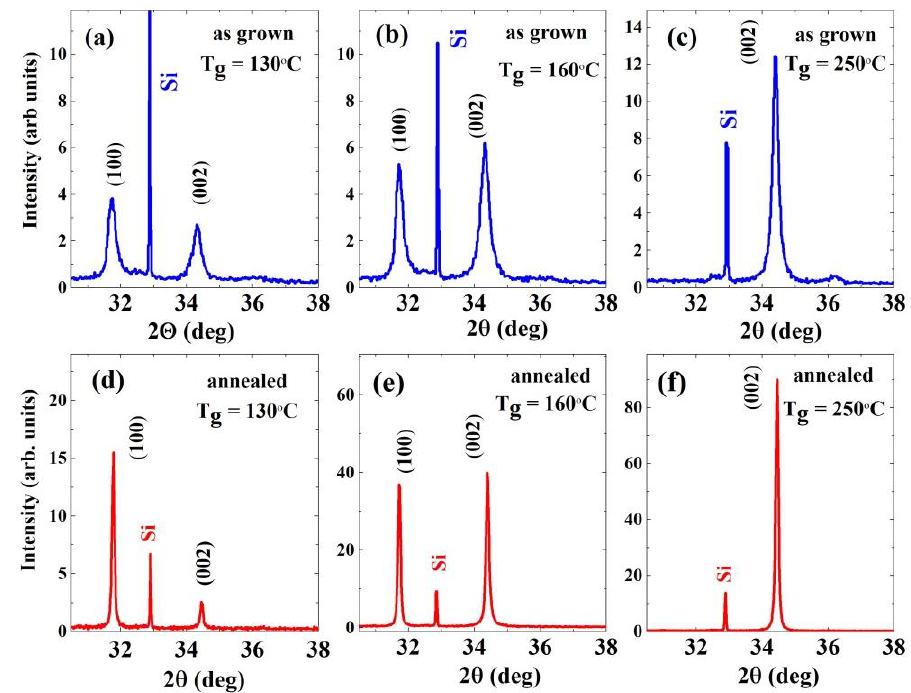
Figure 1. X-ray diffractograms of as grown ( a – c ) and annealed ( d – f ) ZnO/Si (100) films grown at 100 °C, 160 °C, and 250 °C.